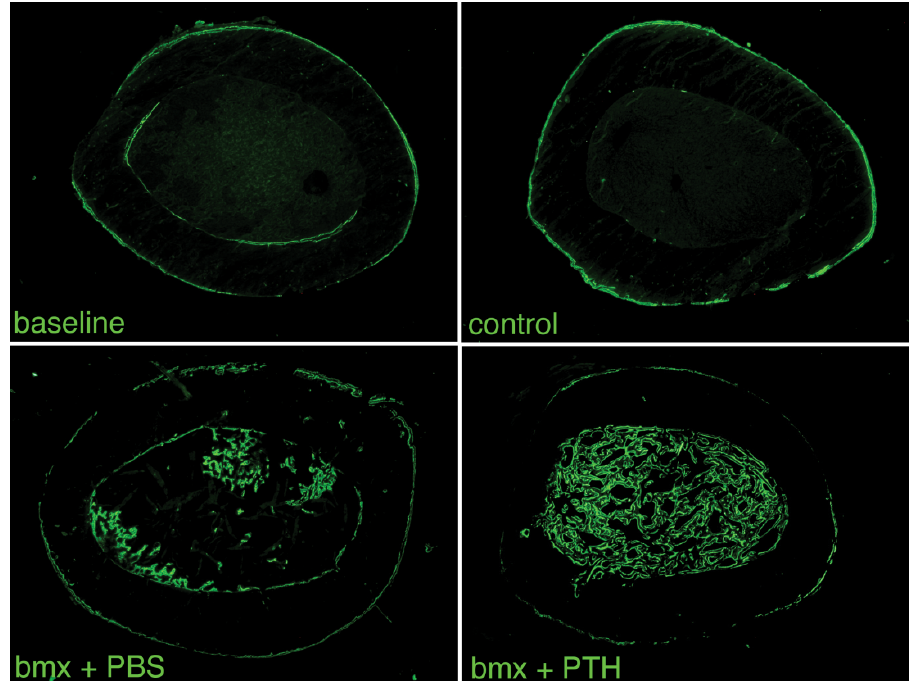
Figure 6. Cross sections of femoral shafts of left operated femurs from baseline, control and bone marrow-ablated (bmx) rats treated five days per week with PBS or PTH for 28 days. The intramedullary bone formed in response to marrow ablation followed by treatment with PTH is undergoing calcification, as demonstrated by the intense fluorescent signal viewed under UV